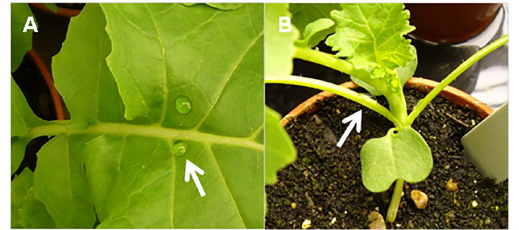
Figure 2. Leaf lamina and leaf petiole inoculation . Inoculation of oilseed rape leaf lamina (A) or leaf petiole (B) with conidia or ascospores of Leptosphaeria maculans . The arrows indicate the droplets of spore suspension (either conidia or ascospores) placed on the lamina (A) or petiole (B) of leaves of doubled haploid lines A30 (susceptible) or C119 (with quantitative resistance). Plants were inoculated at 21 days after sowing when they had three fully expanded leaves.